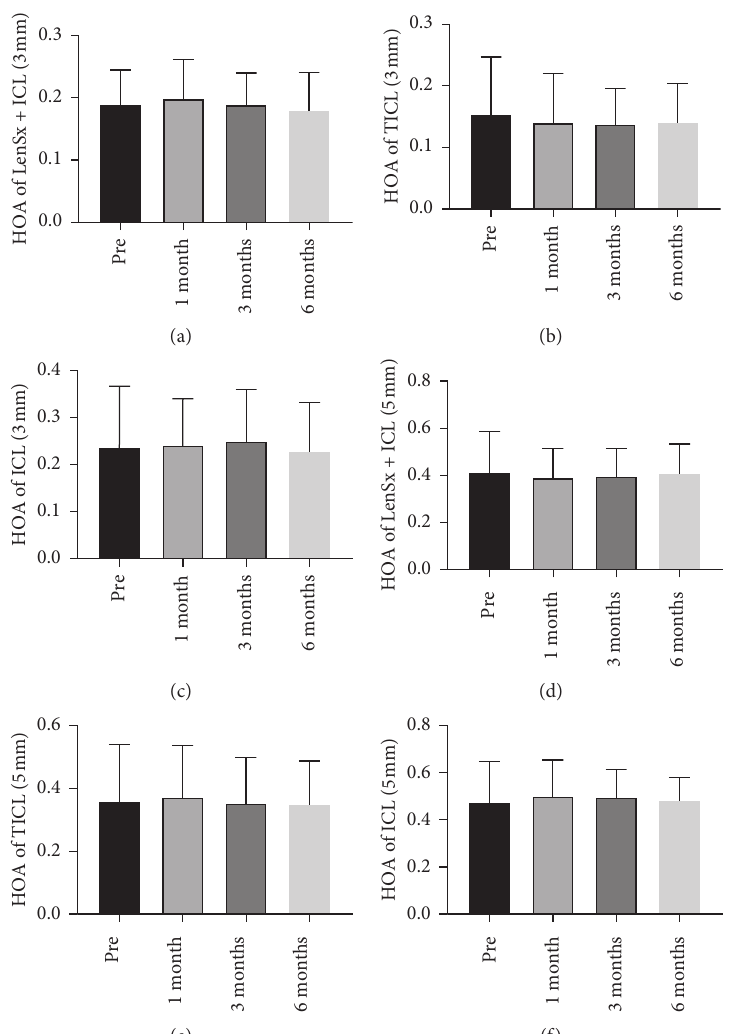
Figure 8: The total high-order aberrations in the three groups before and after surgery at 1, 3, and 6 months (the results are expressed as the means ± SD).